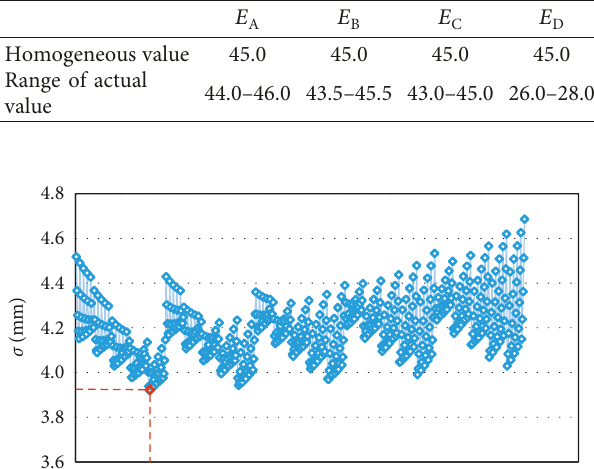
Figure 12: Separation results of pendulum radial displacement increment. Table 2: Standard deviations of the combined results of E Table 3: Assumed elastic modulus range of A, B, C, and D zones A and E D . (GPa). E D